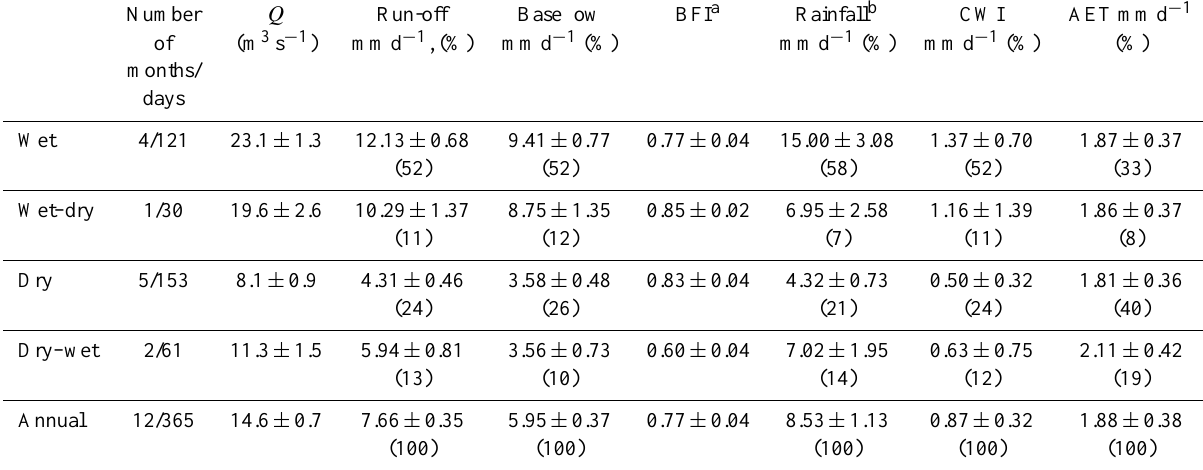
Table 2. Water budget components for the Kosñipata catchment at the San Pedro (SP) gauging station, for the annual period from Febru- ary 2010 to January 2011. Percentages indicate fraction of the annual total for that component.